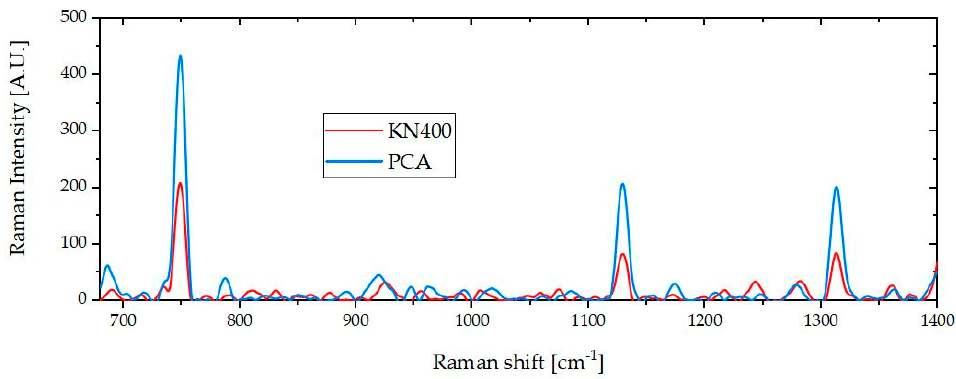
Figure 3. Processed Raman spectra of suspended cultures, showing an example of the difference between PCA and KN400, which is related to the cytochrome-c quantity and oxidation state. Both samples had an OD600 of 0.24.